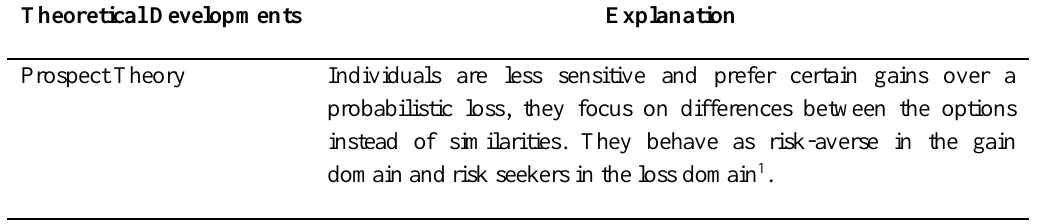
Table.1. Theoretical Developments in the Context of Investors’ Biases and Stock Return Volatility